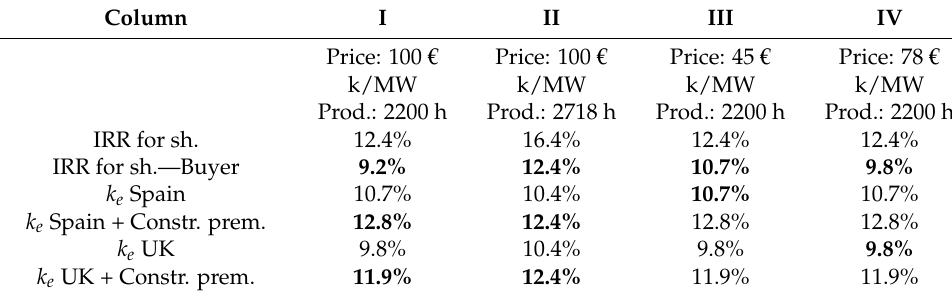
Table 9. IRR for shareholders and cost of equity. Column I II III IV Price: 100 €